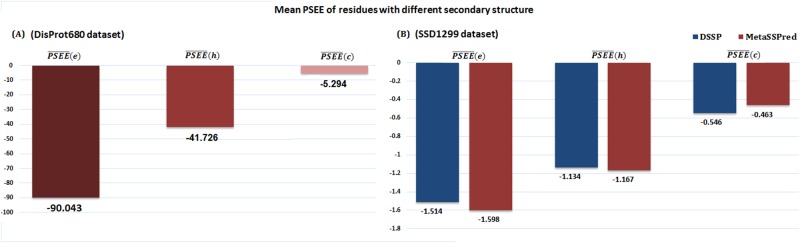
Secondary structure residue type characterization of PSEE.(A) Mean PSEE for beta (dark brown bar), helix (brown bar) and coil (light brown bar) residues of DisProt680 dataset. (B) Mean PSEE for beta, helix, and coil residues of SSD1299 dataset. The blue and brown set of bars represent the annotations from DSSP and MetaSSPred, respectively. The bars are label with the respective mean PSEE values.